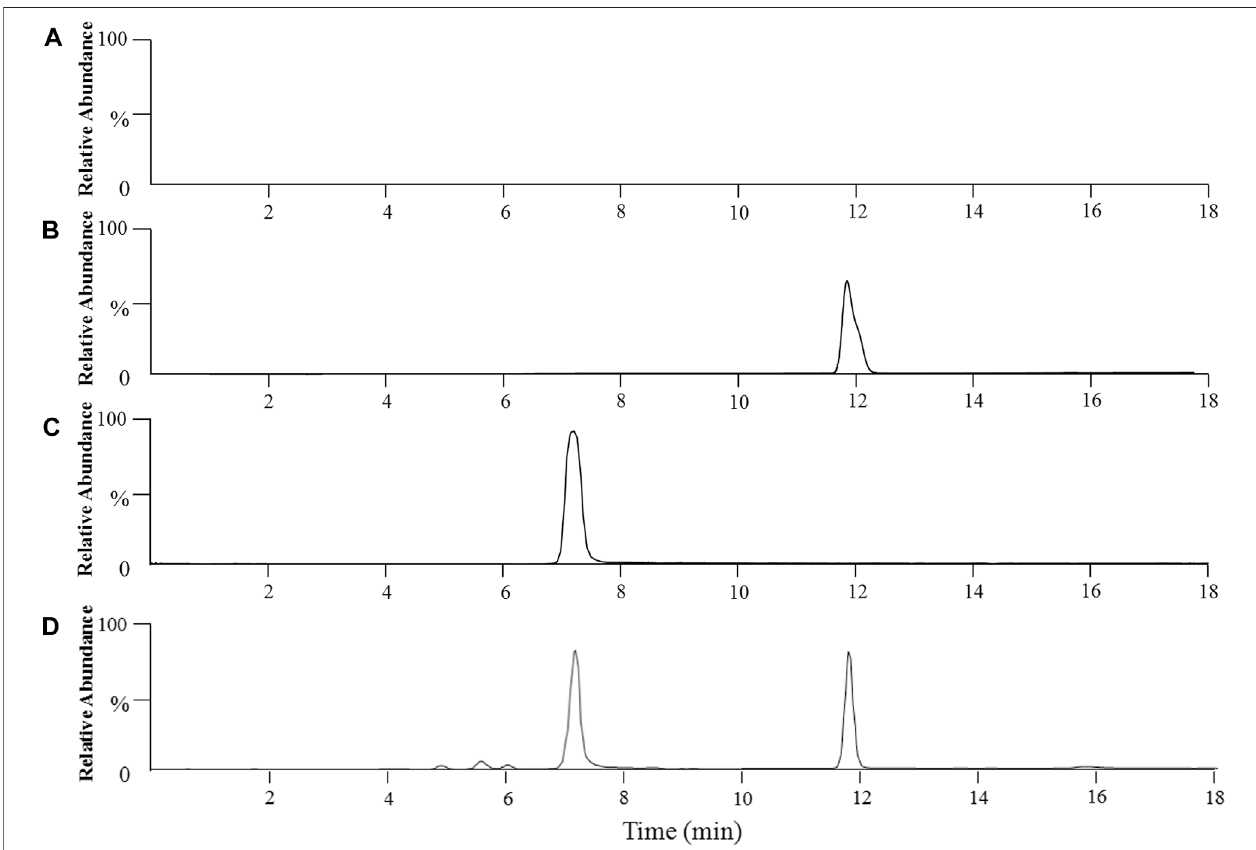
FIGURE 1 | Representative chromatograms of anwulignan and schisandrin A in the plasma of mice. Note: (A) blank plasma; (B) blank plasma spiked with anwulignan; (C) blank plasma spiked with schisandrin A; (D) a mice plasma sample collected after administration of a single dosage of anwulignan (3 h).